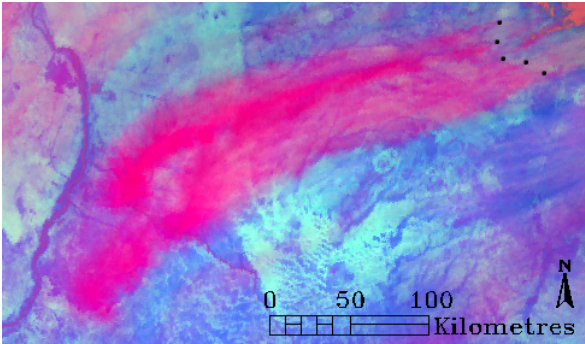
Figure 2. VIIRS Dust RGB (Lensky and Rosenfeld, 2008) show- ing dust being emitted northeast of the Sudanese Nile (latitude 18 ◦ , longitude 35 ◦ ) on 19 December 2016. Dust point source locations are identified by tracking dust plumes back to their first point of